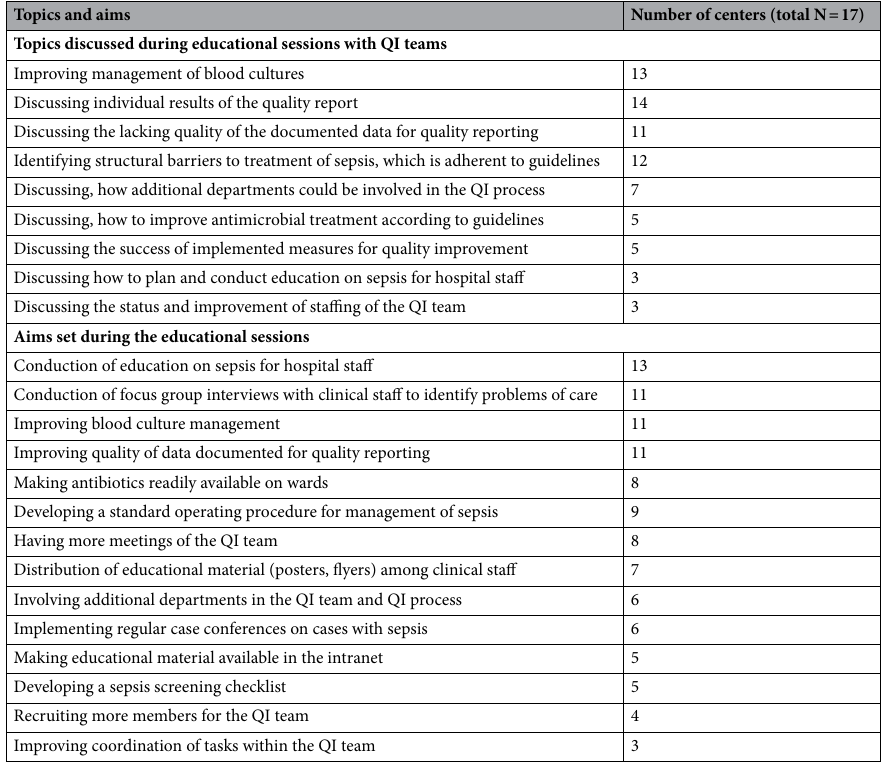
Table 2. Contents of the educational sessions of study coordinators with quality improvement teams. Results of qualitative analyses of open-ended questions distributed to study coordinators after each educational session with quality improvement (QI) teams of intervention hospitals during implementation phase. Data were available for 17 QI teams. Every category was only counted once per QI team. Only categories present among at least three QI teams are shown.